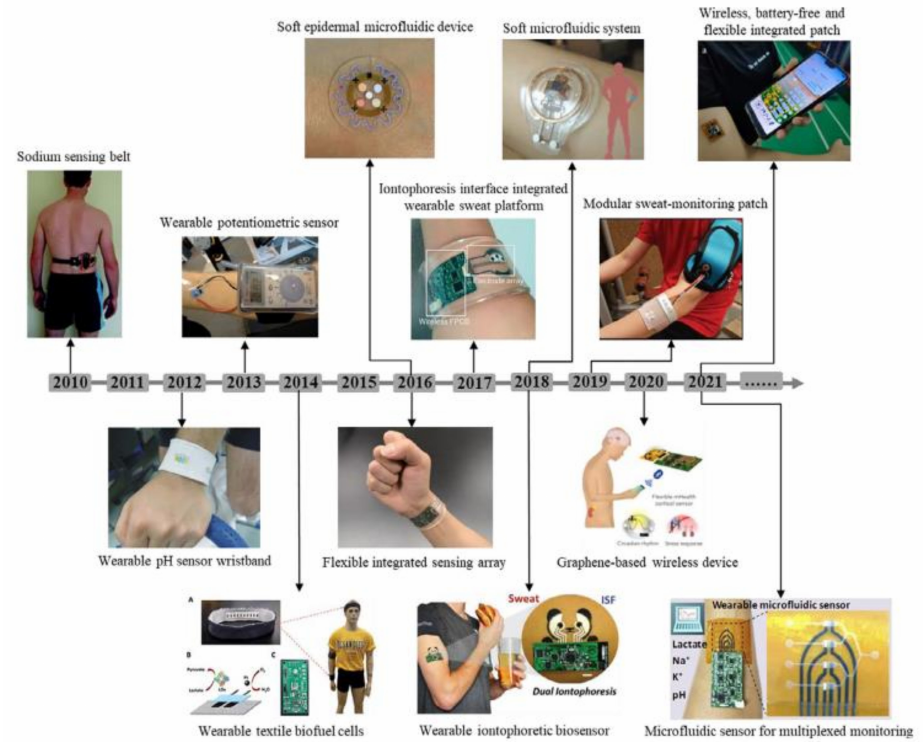
Figure 16. Over the last decade, examples of integrated wearable sweat sensors have been created. (Reproduced from [404] with permission. Copyright 2021, Elsevier, Amsterdam, The